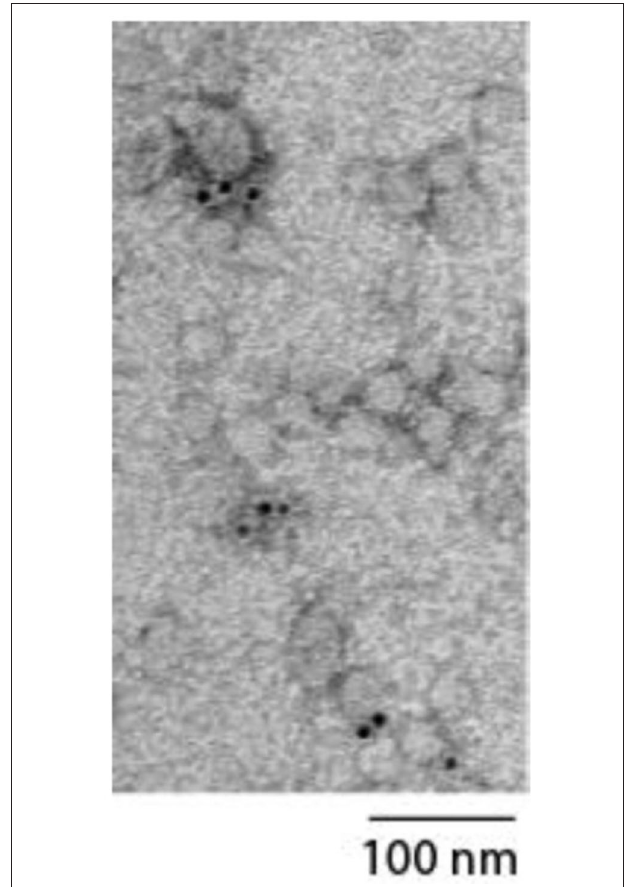
FIGURE 1 | Electron micrograph showing particles measuring between 50 and 100nm labeled with gold beads indicating the presence of CD81 +